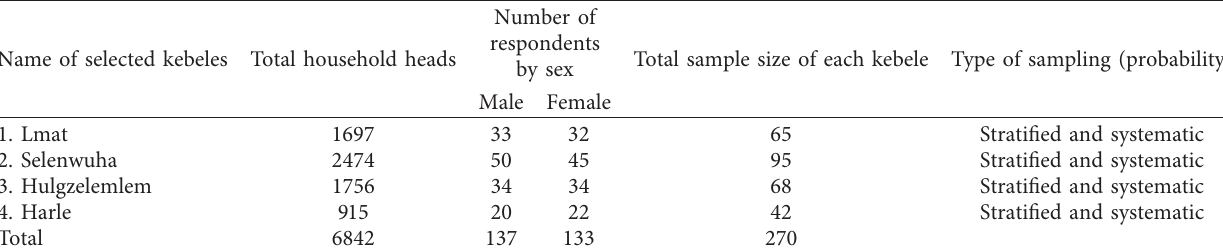
Table 1: The targeted kebeles, their respective household numbers, and the sample size to be taken from each kebele (sampling frame) using a proportionate stratified sampling